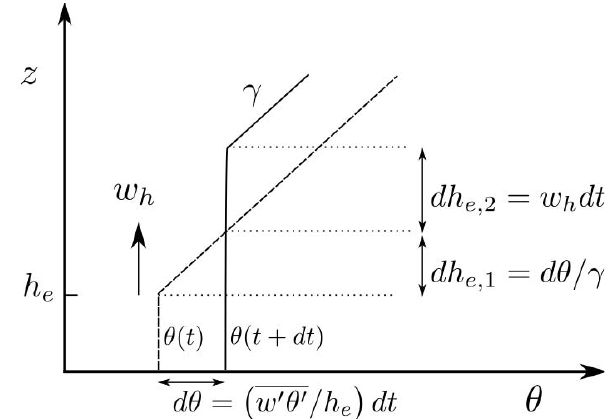
Fig. 2. The evolution of the vertical potential temperature profiles for the CBL as a function of height z . The vertical velocity is indi- cated with w h . d θ represents the mixed-layer temperature change (cid:16) (cid:17) w 0 θ 0 due to the surface heat flux . γ is the temperature slope above the mixed-layer height h e . d h e, 1 and d h e, 2 are the changes in mixed-layer height due to the surface sensible heat flux and vertical velocity. The thick dashed line depicts the temperature profile time t , and the full lines that of a time step d t later. θ(t) and θ(t + d t) are the corresponding mixed-layer temperatures.